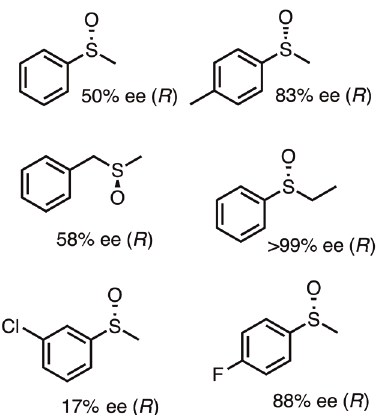
Figure 17 - Several sulfoxides prepared from oxidations with Dietzia